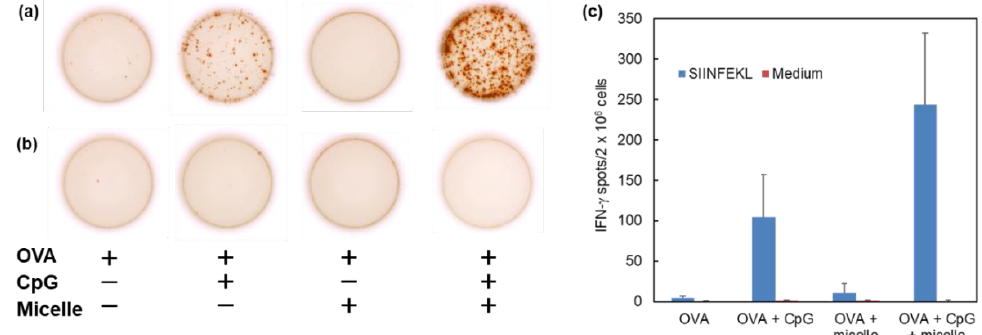
Figure 6. Induction of cellular immunity by pH-responsive micelles. C57BL/6 mice were immunized intradermally with 16 µ g of OVA, OVA + CpG-ODN, or OVA + DLPC/deoxycholic acid micelle or OVA + CpG-ODN + DLPC/deoxycholic acid micelle. Splenocytes (2 × 10 6 cells) were collected from the immunized mice on day 7 after immunization and were cultured with ( a ) or without ( b ) OVA CTL epitope peptide (SIINFEKL) for 40 h. ( a , b ) Typical micrographs of IFN- γ -producing spots measured by ELIspot. The number of IFN- γ -producing spots is shown ( c ).